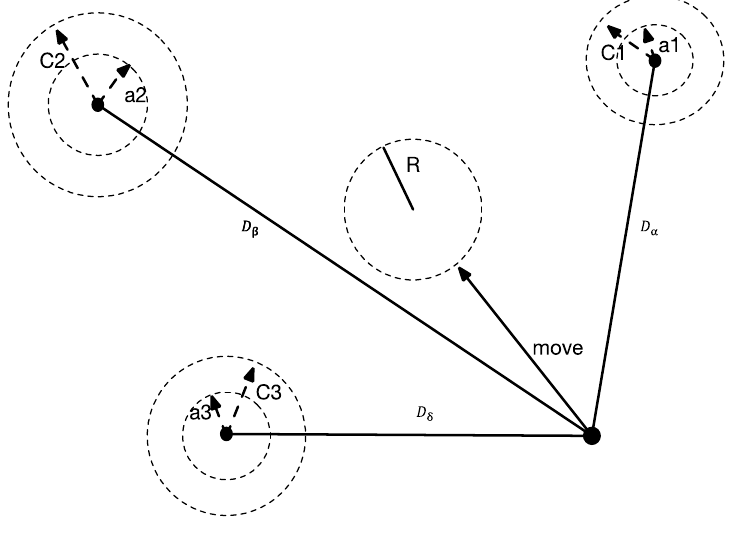
Figure 1. The movement of the wolves.